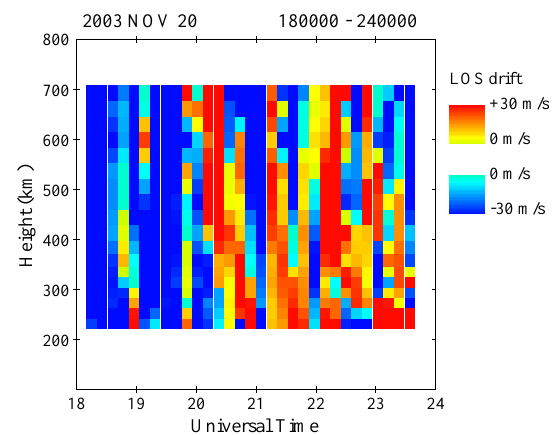
Figure 12. Line-of-sight (LOS) velocities measured by the Sondre- strom radar on 20 November 2003, when the antenna was pointing in the direction parallel to the local magnetic